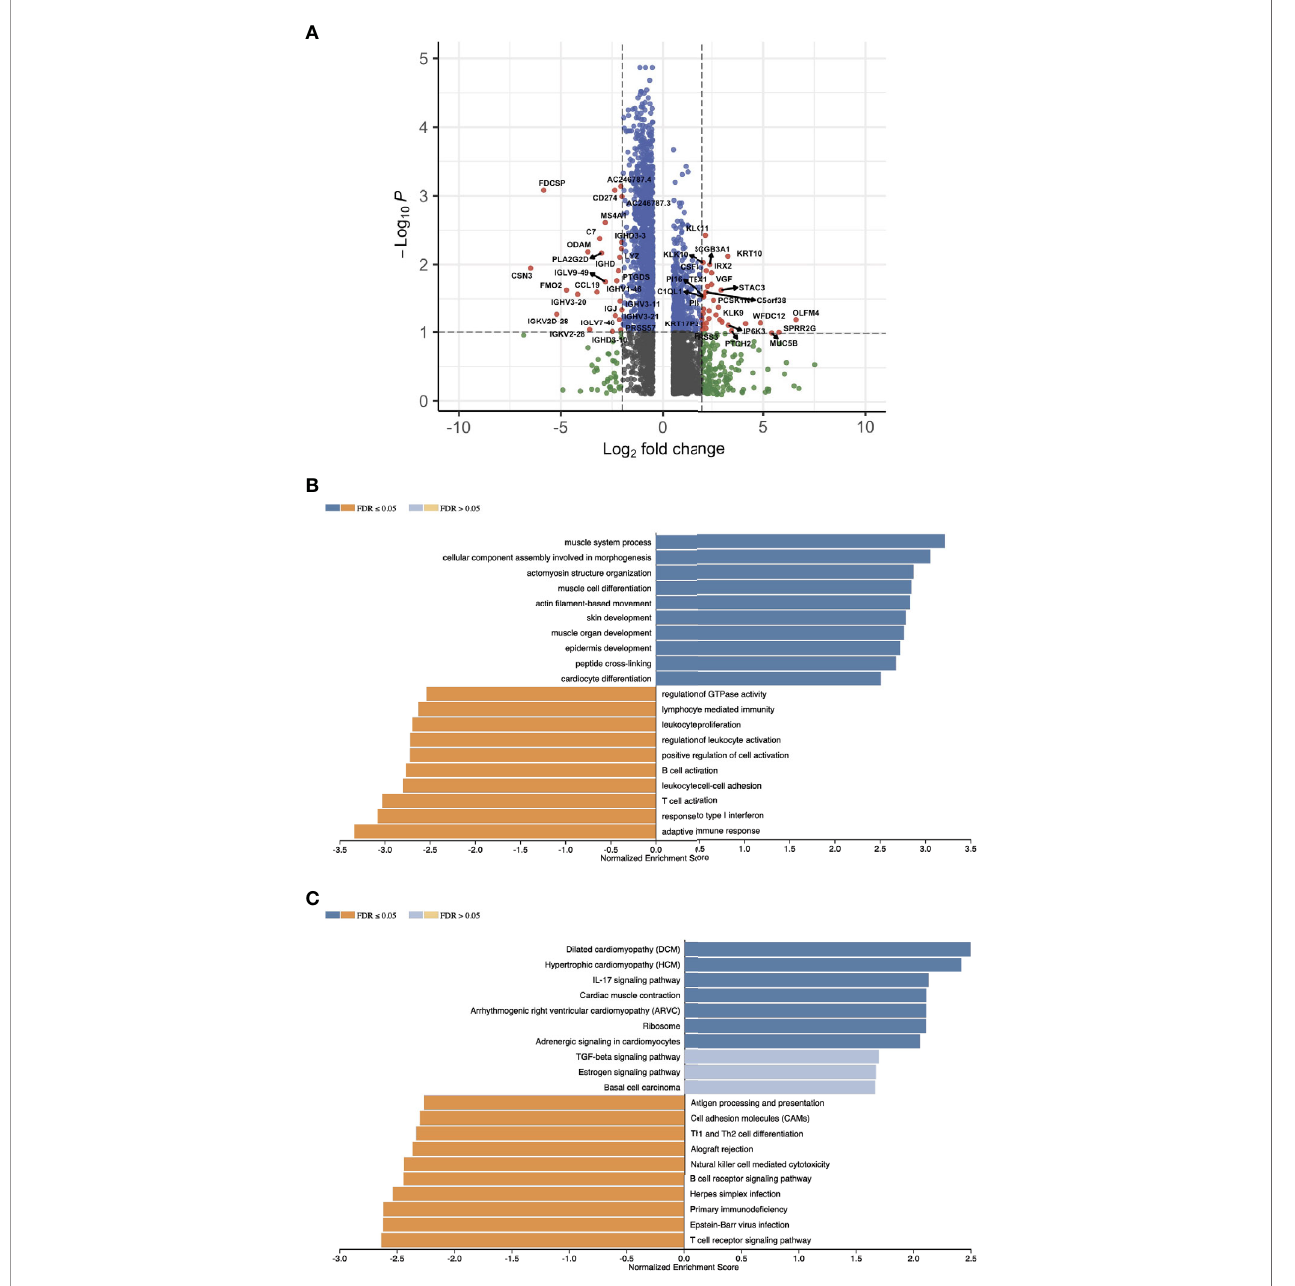
FIGURE 7 | Pro fi ling the gene expression of the HPV+ HNSCC risk groups. (A) A volcano plot of the DEGs between high and low risk groups of HPV+ HNSCC TCGA samples. (B) Bar graphs showing the enriched gene ontology (GO) Biological Process of the risk DEGs and (C) the enriched KEGG